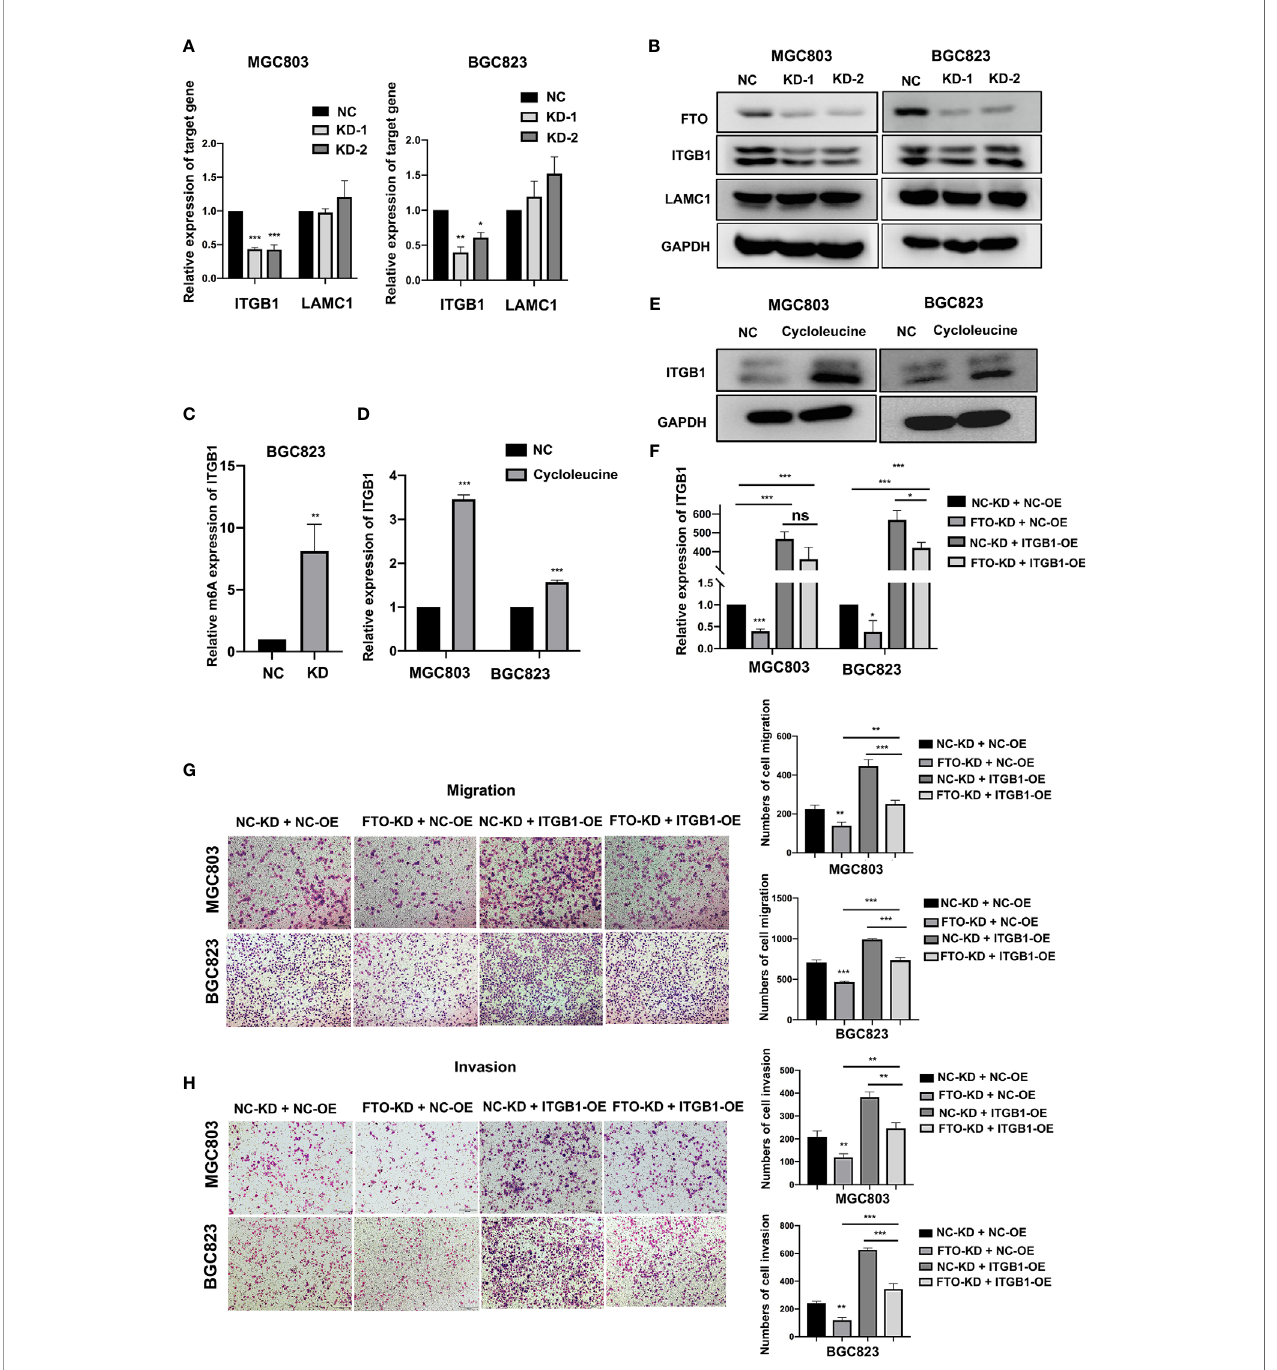
FIGURE 6 | Identi fi cation of ITGB1 as FTO demethylated target gene in GC cells. (A, B) The relative mRNA and protein expression level of ITGB1 and LAMC1 in BGC823 and MGC803 cells after transfected with siNC or FTO siRNAs were detected by qRT-PCR and Western blot. (C) The m6A modi fi cation level of ITGB1 in BGC823 cell transfected with siNC or FTO siRNAs was detected by MeRIP-qRT-PCR. (D, E) The relative expression of ITGB1 in MGC803 and BGC823 cells after added with cycloleucine were detected by qRT-PCR and Western blot. (F) The relative expression of ITGB1 in BGC823 and MGC803 cells after co-transfected with siNC or FTO siRNAs and ITGB1 plasmids or empty vectors was detected by qRT-PCR. (G, H) The migration and invasion ability of BGC823 and MGC803 cells after co-transfected with siNC or FTO siRNAs and ITGB1 plasmids or empty vectors was examined by transwell assay (original magni fi cation, 100×). The columns on the right are quanti fi ed by counting 3 fi elds, and presented as the mean ± standard deviation. Data are presented as the mean ± SD of three independent experiments. * P < 0.05, ** P < 0.01, *** P < 0.001, ns, not statistically signi fi cant. 18S was used as an internal control for all qRT-PCR experiments. GAPDH was used as an internal control for all western blot